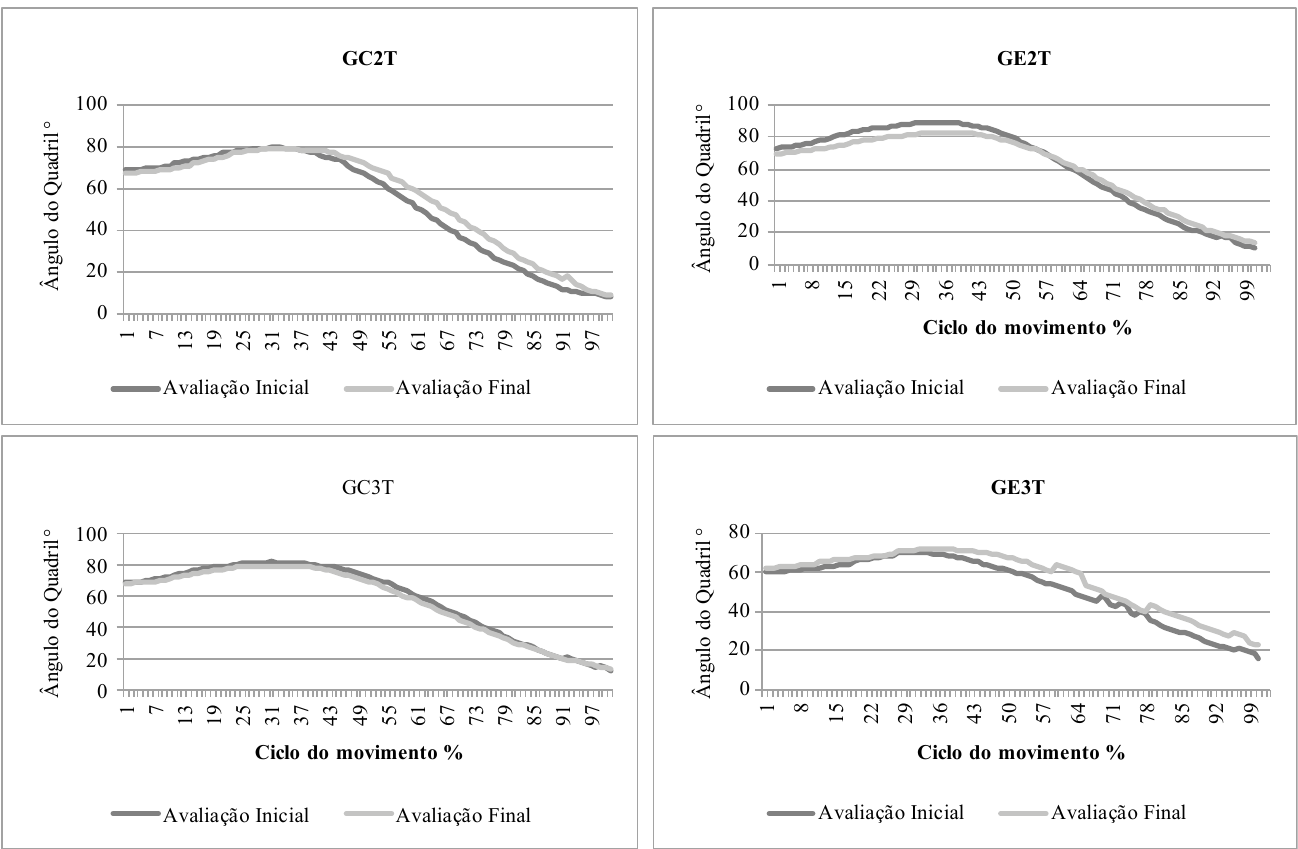
Figure 2. Angular displacement means of the hip joint during the sit-to-stand